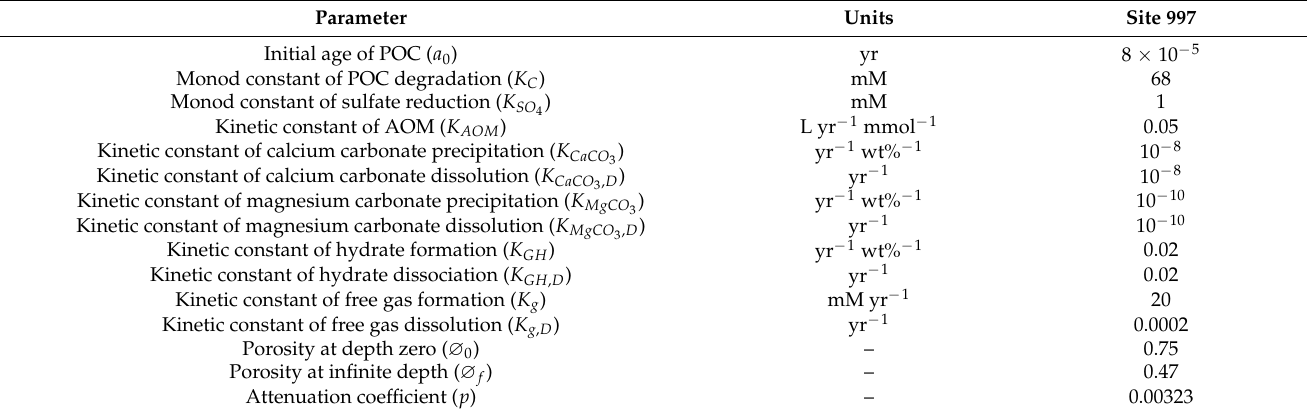
Table A4. Parameters’ value derived by fitting the model to data.